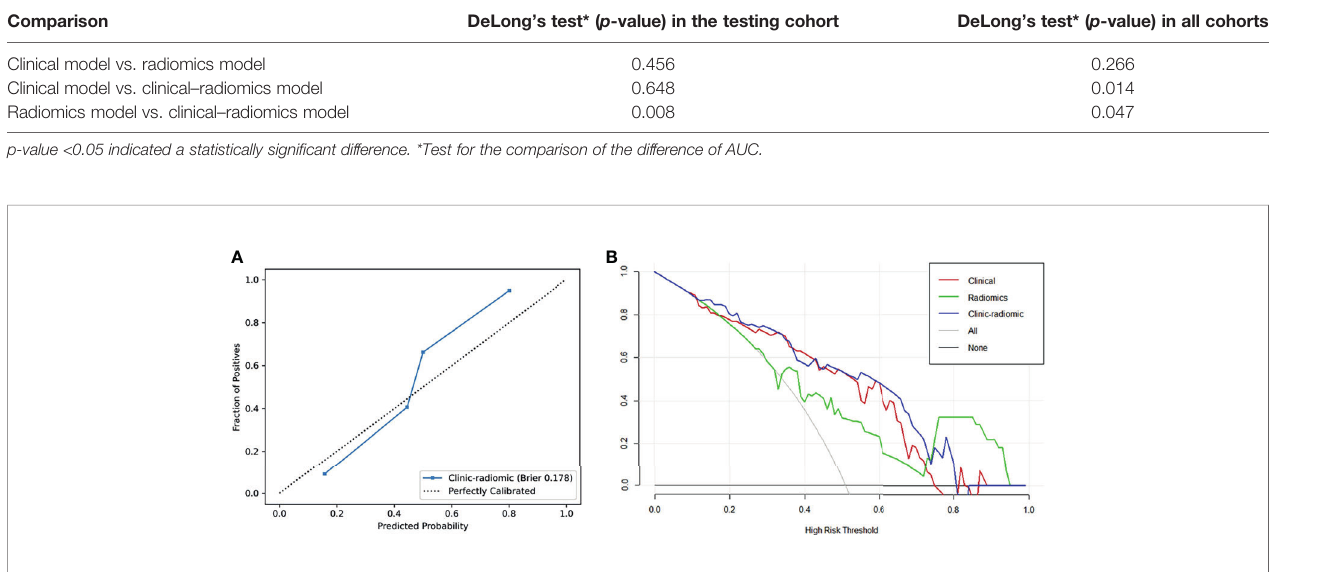
FIGURE 3 | (A) Calibration curve of the clinical – radiomics model. (B) DCA curves of the clinical, radiomics, and clinical – radiomics model.